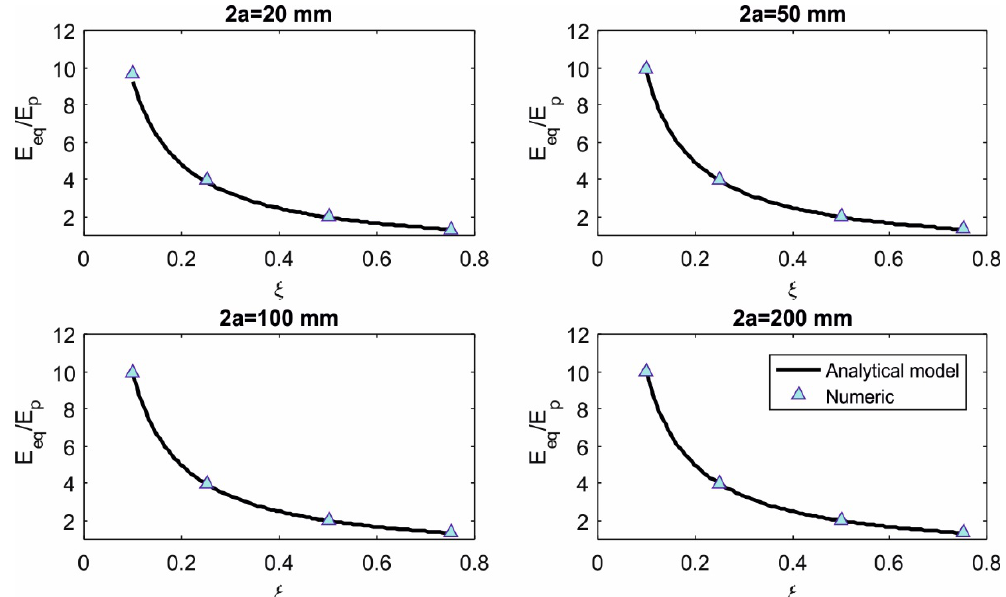
Fig. 5 Ratio E eq / E p , as a function of the percentage of detached interlayer ξ = λ / a , for different values of the fragment length 2 a and for interlayer thickness of 0.76 mm. Comparison between analytical and numerical